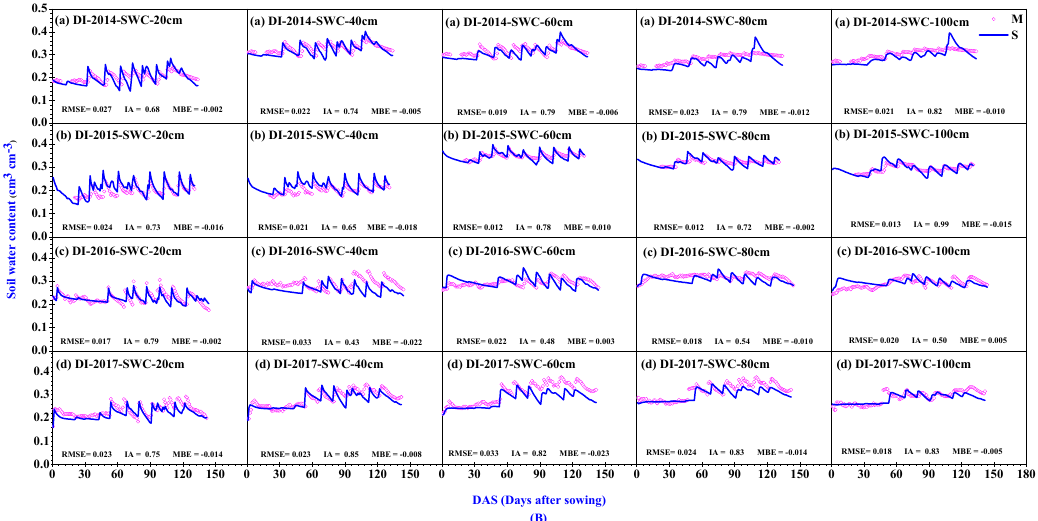
Figure 1. Comparison of measured values (M) and simulated values (S) of soil water content under border-irrigated (BI) treatment and drip-irrigated (DI) treatment in different depths (20 cm, 40 cm, 60 cm, 80 cm, 100 cm) during 2014–2017, respectively. Figure ( A ) represents BI; figure ( B ) represents DI.